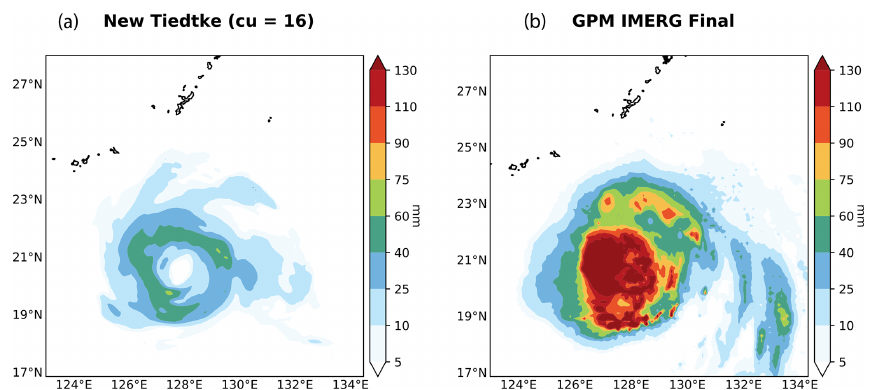
Figure 1. Comparison between simulated 6h accumulated surface liquid precipitation with the new Tiedtke convection parameterization in the WRF model using GFS initial and boundary conditions (cumulus option 16 in WRF, a ) and the GPM IMERG final run (b) for Typhoon Megi on 25 September 2016 from 18:00UTC. The accumulated precipitation includes cumulus, shallow cumulus, and grid-scale rain. The domain is located over the Philippine Sea with a horizontal grid size of 10km. Radiation scheme: RRTMG shortwave and longwave schemes, boundary layer scheme: Mellor–Yamada–Janji´c scheme, microphysics scheme: NSSL two-moment scheme, land surface